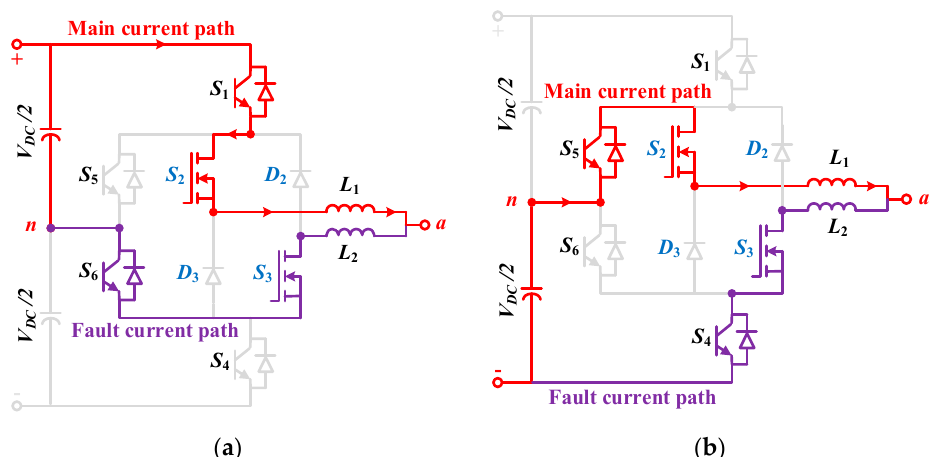
Figure 6. Shoot through fault current paths of the hybrid ANPC inverter during ( a ) state O 3 to state P for positive half cycle, ( b ) state O 2 to state N for the negative half cycle.